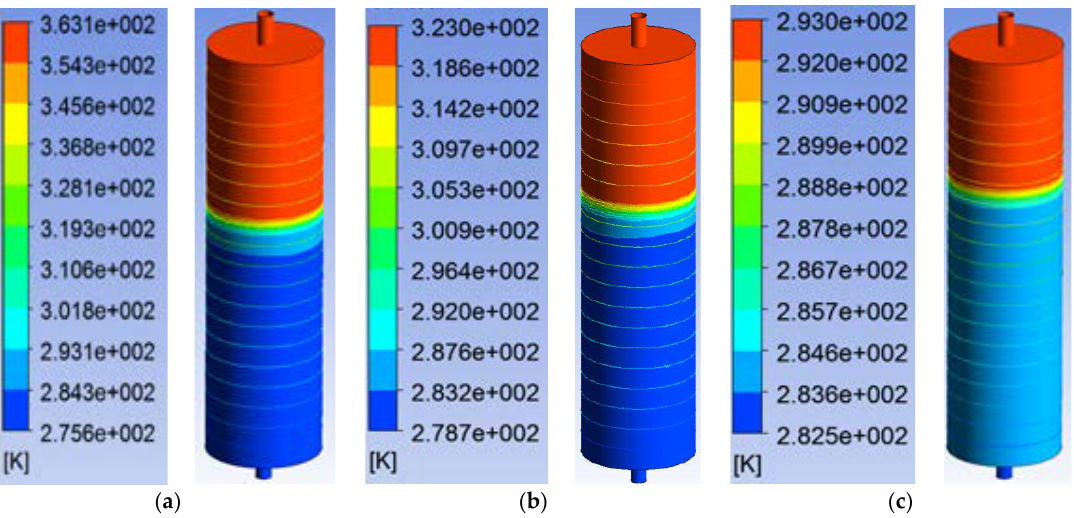
Figure 8. Temperature profiles in TES-1 at temperature differences of ( a ) 84 °C, ( b ) 44 °C and ( c ) 14 °C.